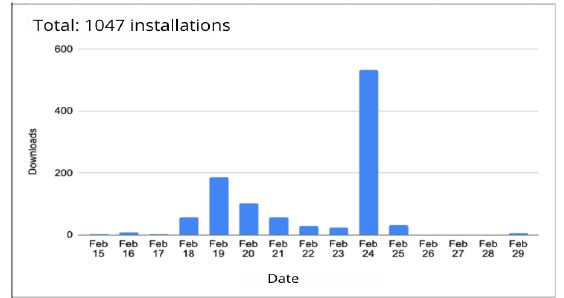
Figure 8. Installations chart on Android devices